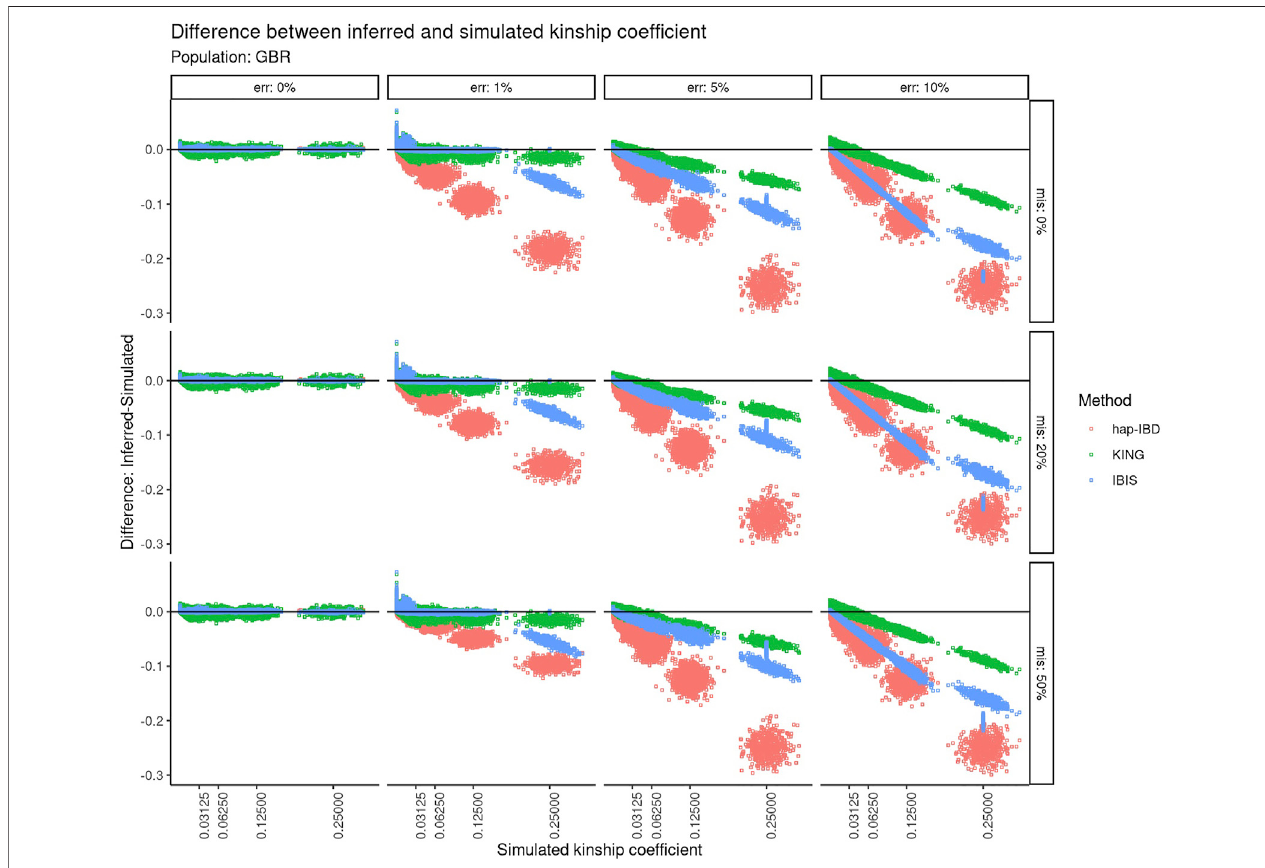
FIGURE 3 | Difference between the inferred kinship coef fi cient versus the true simulated kinship coef fi cient for three different methods using default parameters at different error and missingness levels for simulated relationships from GBR founders. Error increases in panels going left-to-right. Missing data increase in panels going top-to-bottom. Each point represents a pair of simulated individuals. Red = hap-IBD; green = KING; blue = IBIS.